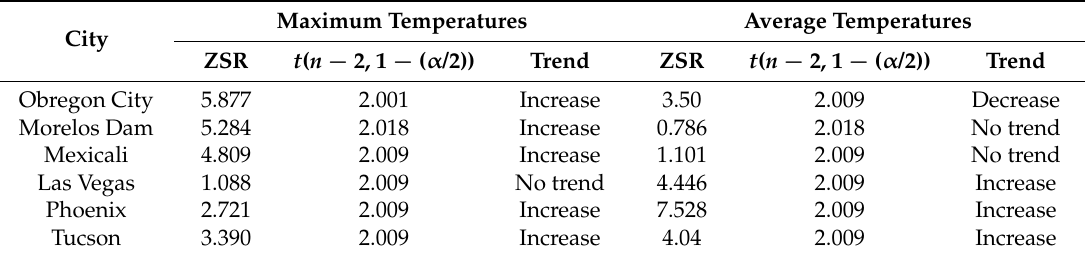
Table 2. Results of Spearman’s rho test for September at a significance level of α = 0.05.